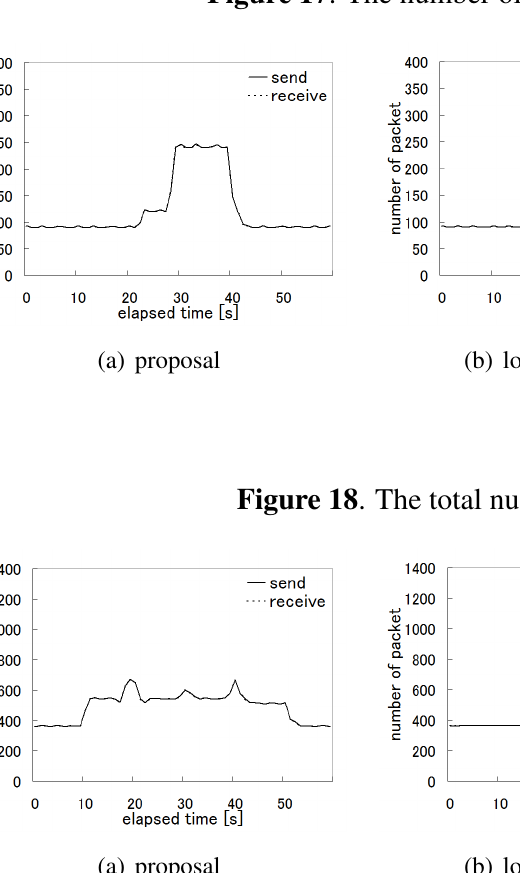
Figure 17 . The number of sent and received packets (Node C).